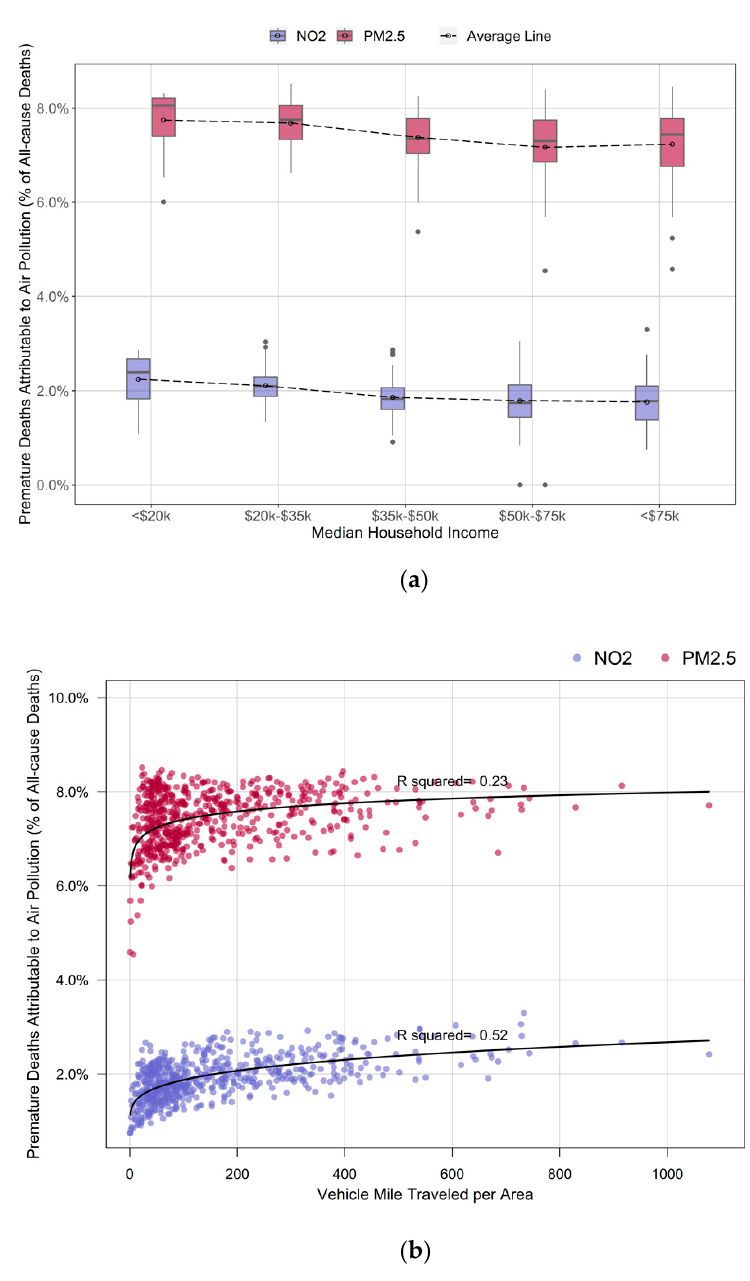
Figure 5. Variation of the percentage of premature deaths attributable to air pollution from all-cause deaths by ( a ) median household income, and ( b ) road traffic .